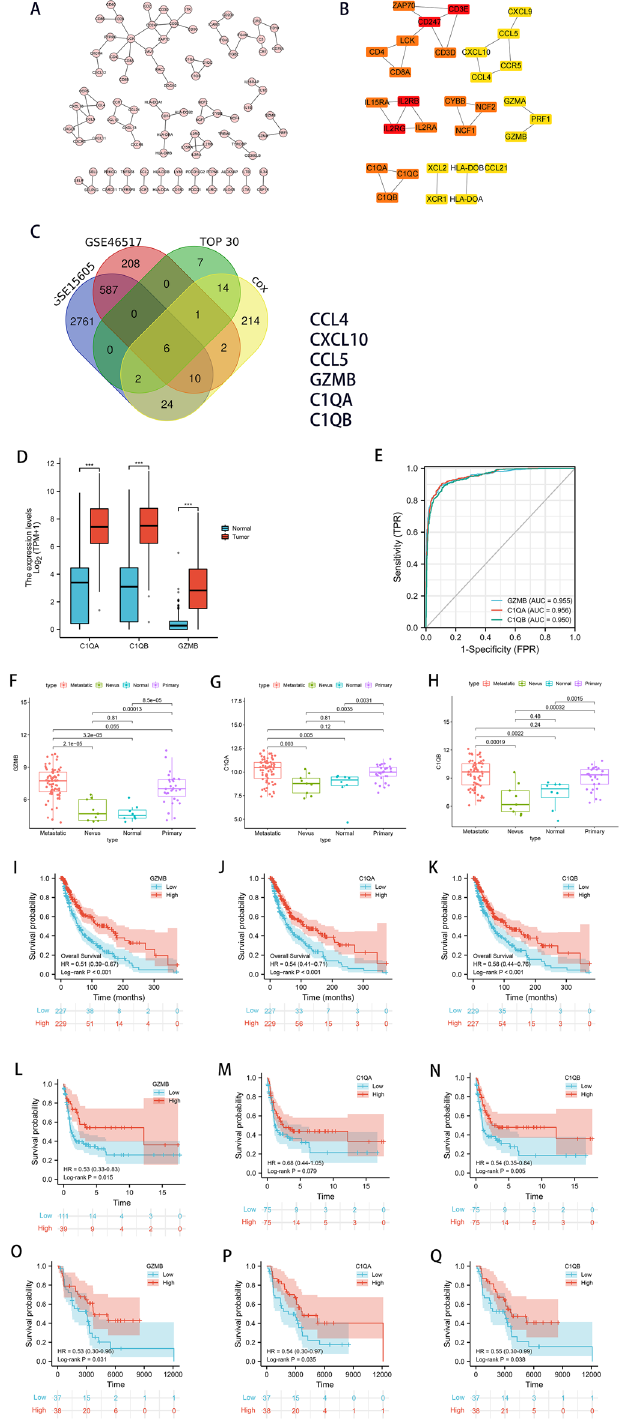
Figure 5. Visualization of the PPI network and correlation of expressions of GZMB, C1QA, and C1QB with clinicopathologic features. ( A ) PPI network based on STRING confidence score > 0.99. ( B ) Identification of top 30 hub genes in the PPI network using the MNC algorithm. MNC scores increased from yellow to red. ( C ) Venn diagram of the intersection among the functionality-related DEGs, survival-related DEGs, and SKCM-related DEGs. ( D , F – H ) Comparisons of GZMB, C1QA, and C1QB expressions levels in SKCM samples and non- SKCM samples. ( E ) AUCs for GZMB, C1QA, and C1QB expressions. Kaplan–Meier survival curves of GZMB, C1QA, and C1QB in ( I – K ) TCGA, (L-N) GSE65904 and ( O – Q ) GSE54467. This figure was generated using the STRING web tool (https:// string- db. org/), Cytoscape version 3.8.2, and “beeswarm”, “ggpubr”, “Survival”, and “survminer” R